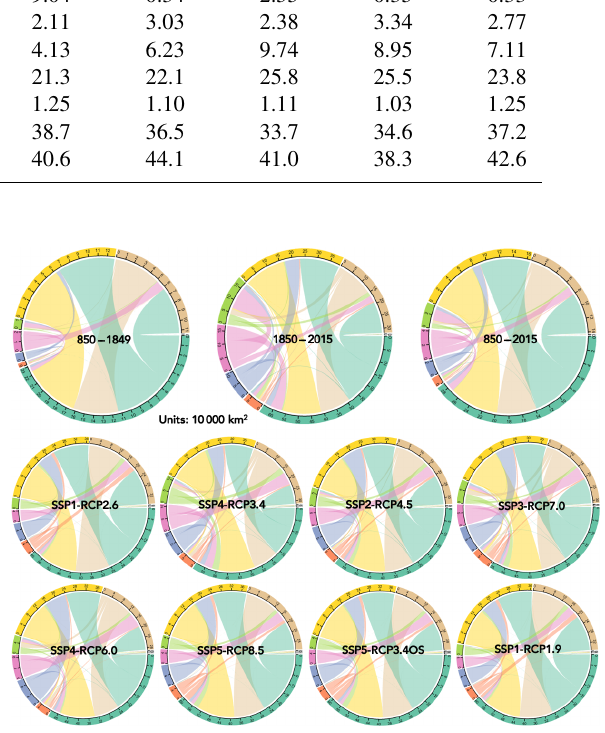
Figure 8. Global land use transitions by time period and by future scenario. Each color represents transitions from a specific land use type to the other land use types: dark green for cropland, orange for managed pasture, blue for primary forest, pink for primary non- forest, light green for rangeland, yellow for secondary forest, brown for secondary non-forest, and grey for